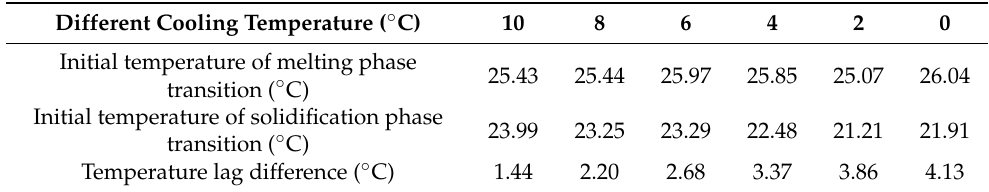
Table 3. Melting initiation temperature and crystallization initiation temperature measured at different cooling